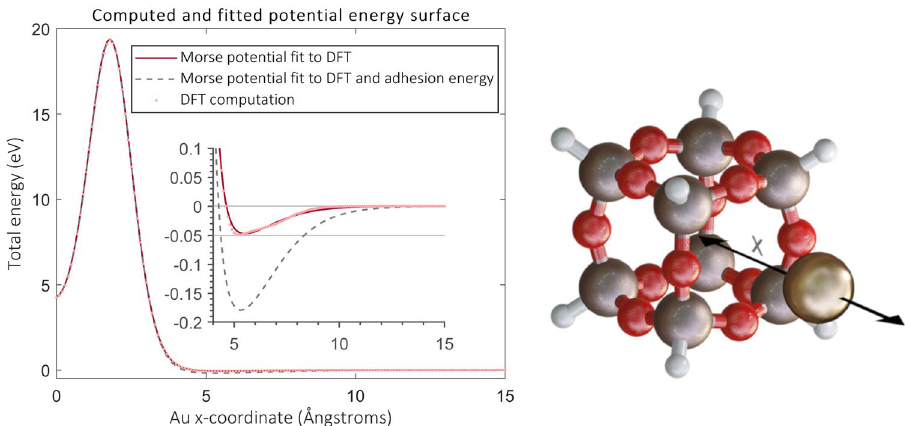
Figure 1. Potential energy surface scan for the Au-H 8 Si 8 O 12 system. The graph on the left shows the data points obtained from the scan, and the Morse potential fits. The inset shows a magnification. The solid line indicates the original potential and the dashed shows the potential after fitting to adhesive energy as explained in the “Methods” Section. The figure on the right shows the geometry of the relaxed molecule and illustrates the x-coordinate. x = 0 points to the middle of the